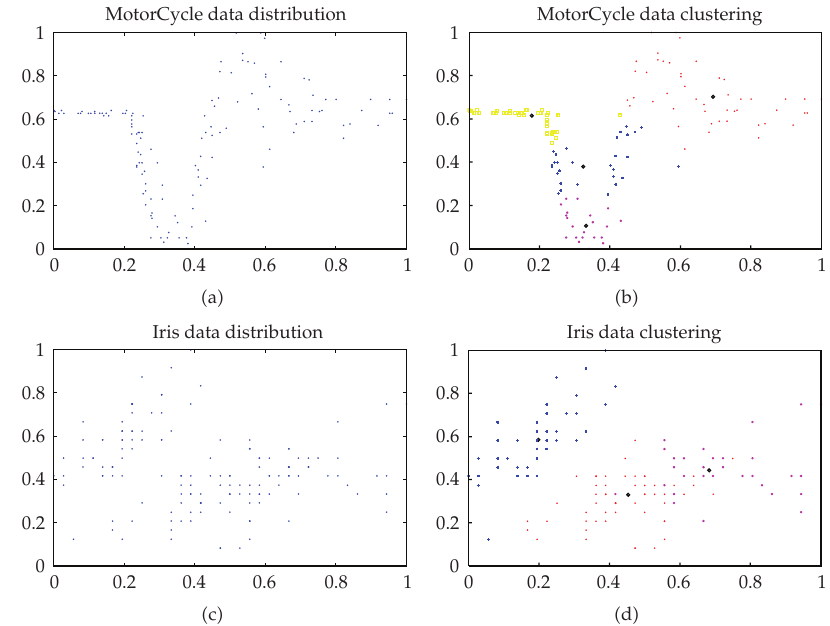
Figure 3: The original data distribution of MotorCycle and Iris data sets and the clustering result by CABC algorithm. (cid:2) a (cid:3) MotorCycle distribution (cid:2) b (cid:3) MotorCycle clustering result. (cid:2) c (cid:3) Iris distribution. (cid:2) d (cid:3) Iris clustering